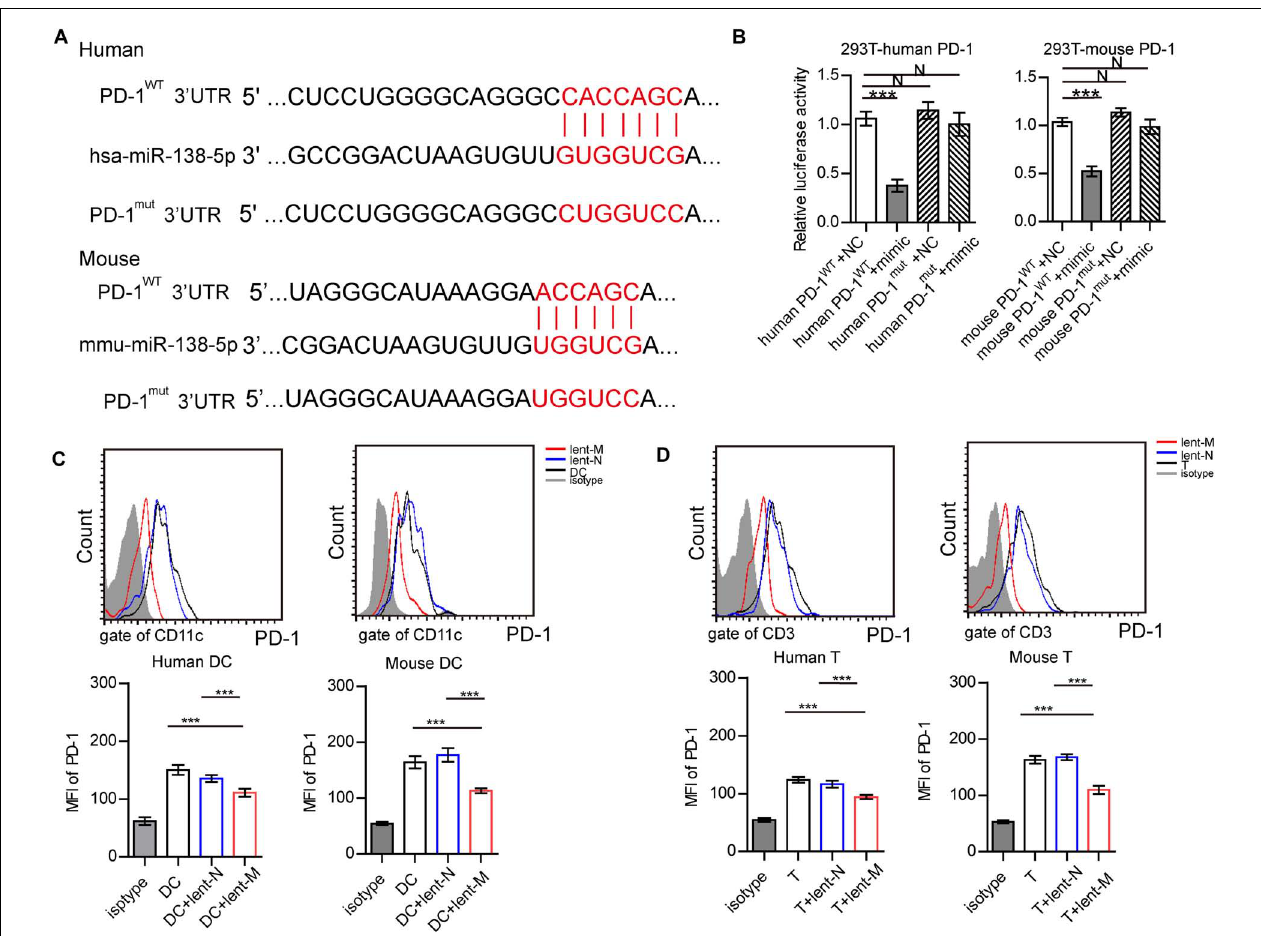
FIGURE 6 | MiR-138-5p targets PD-1 on DCs and T cells. (A) Diagram of the has-miR-138-5p binding site on wild-type (WT) human or mouse PD-1 3 (cid:48) UTR. A mutation was generated at the binding site (Mut). (B) In a dual-luciferase reporter assay, the firefly luciferase reporter containing the WT or Mut PD-1 3 (cid:48) UTR